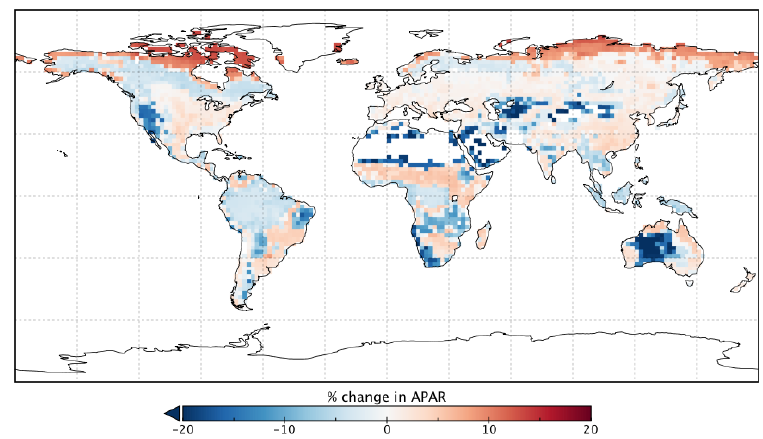
Figure B6. Percentage change in annual mean APAR following the SIF assimilation.